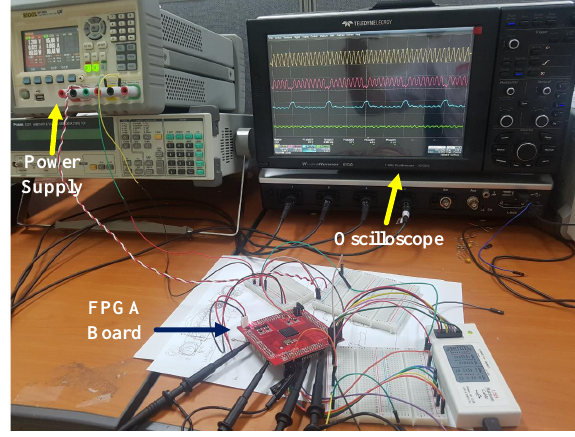
Figure 7. Experimental setup.